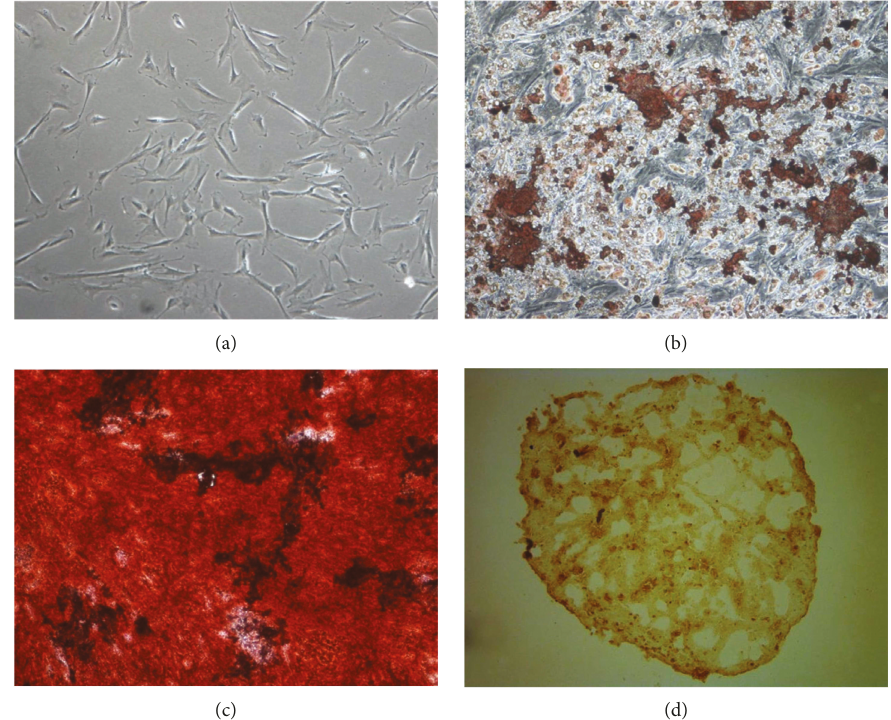
Figure 2: Characteristics of adipose-derived stem cells (ASCs). ASCs showed characteristics of mesenchymal stem cells in the fi broblast-like morphology appearance (a), adipogenesis (b), osteogenesis (c), and chondrogenesis (d) (magni fi cation, 100x).